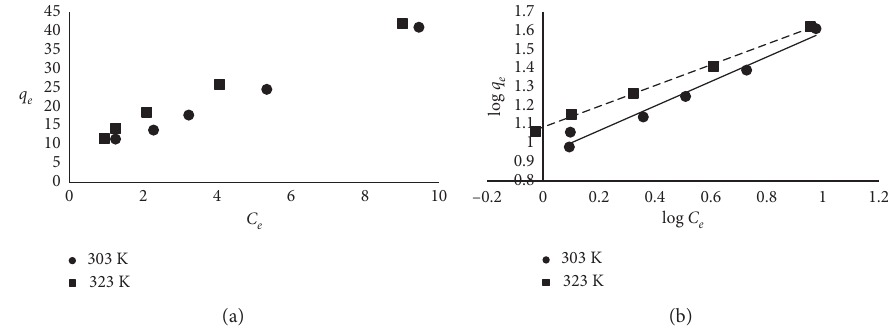
Figure 7: Freundlich isotherm plot for the sorption of methylene blue onto Ginkgo biloba leaves: (a) nonlinear form; (b) linear form (temperature: 303 ° K and 323K; MB concentration: 30mg/L).